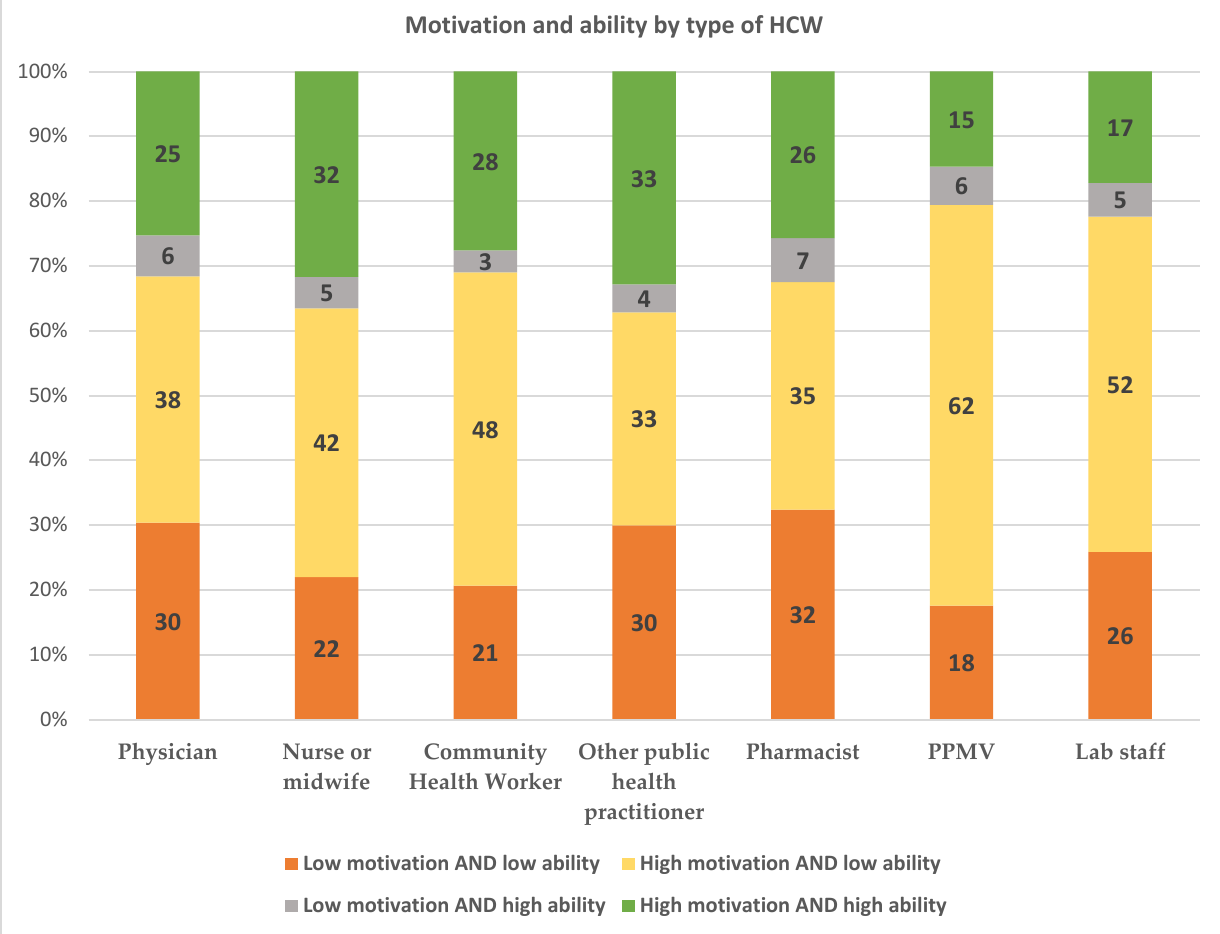
Figure 3. Distribution of motivation and ability by type of HCW.